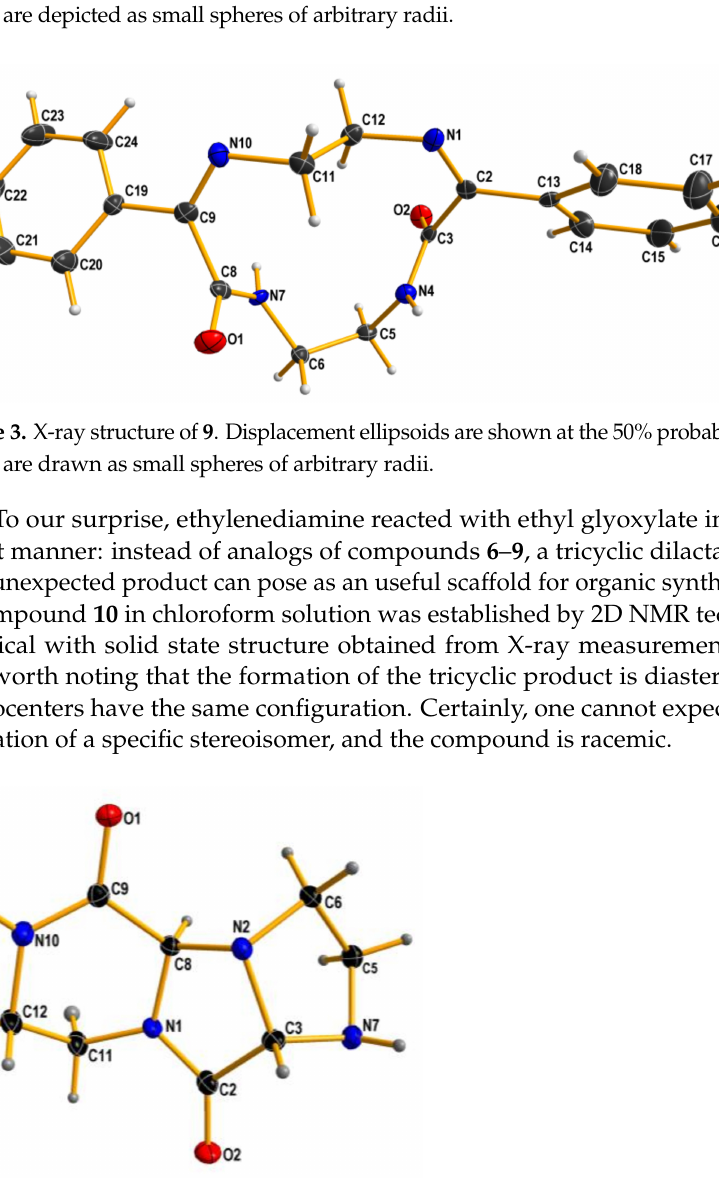
Figure 4. X-ray structure of 10 . Displacement ellipsoids are displayed at the 50% probability level. Hydrogen atoms presented as small spheres of arbitrary